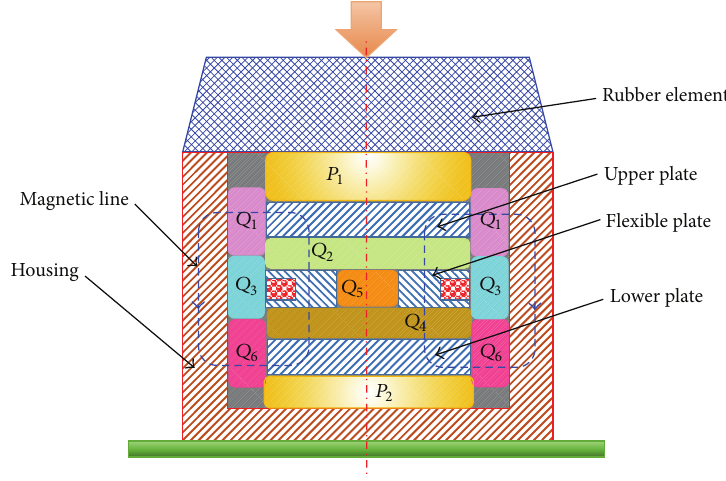
Figure 26: Distribution of inside pressures in mount.